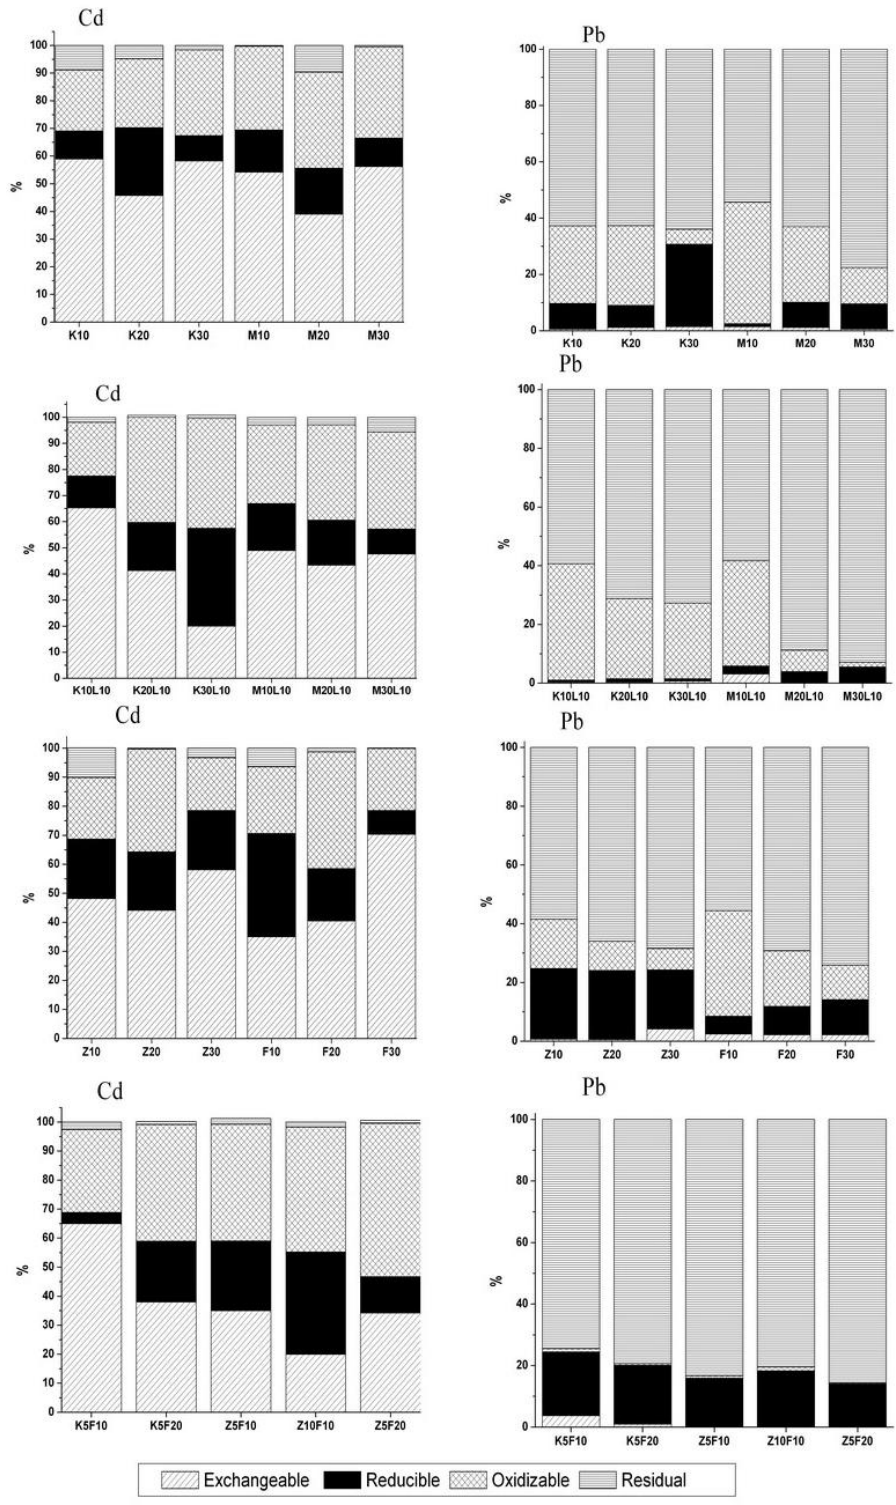
FIGURE 2. Distribution of Cd and Pb in sequentially extracted fractions of treated sediment samples before the ANS 16.1 leaching